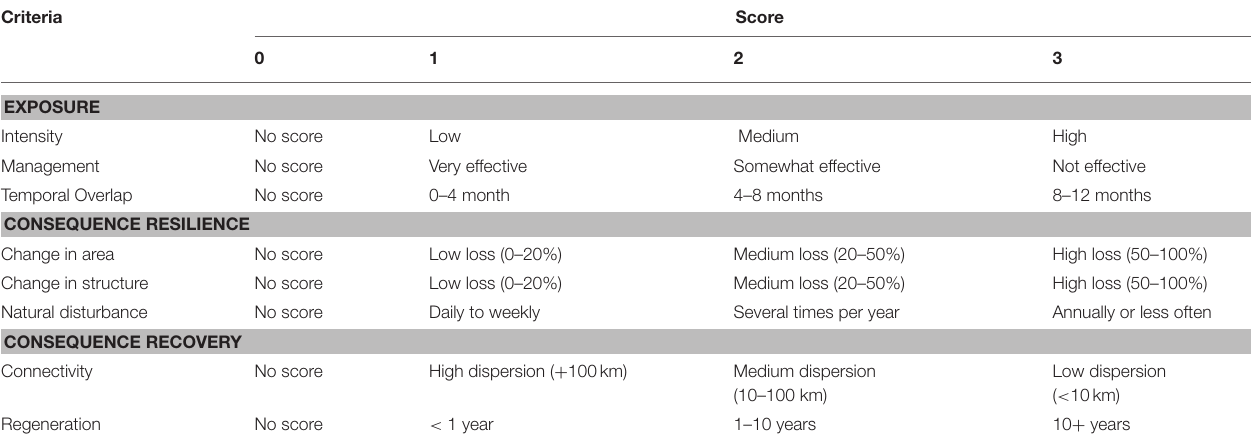
TABLE 2 | The applied criteria and score interpretation applied in HRA model. Criteria